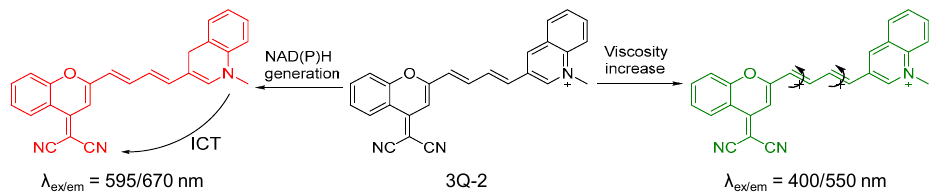
Figure 21. Response mechanism of 3Q − 2 to viscosity and NAD(P)H [83].